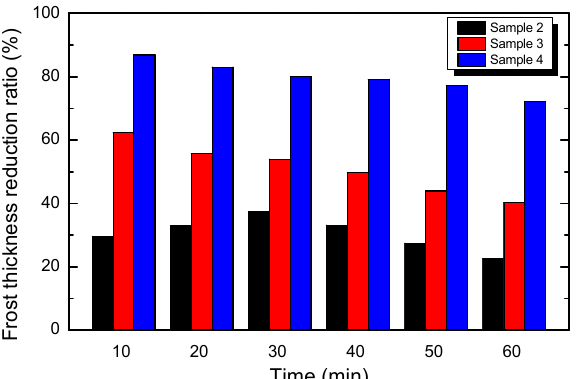
Figure 4. The frost thickness reduction ratio of Sample 2, Sample 3, and Sample 4 at T s = − 15 °C, T a = 5 °C, and φ = 60%.